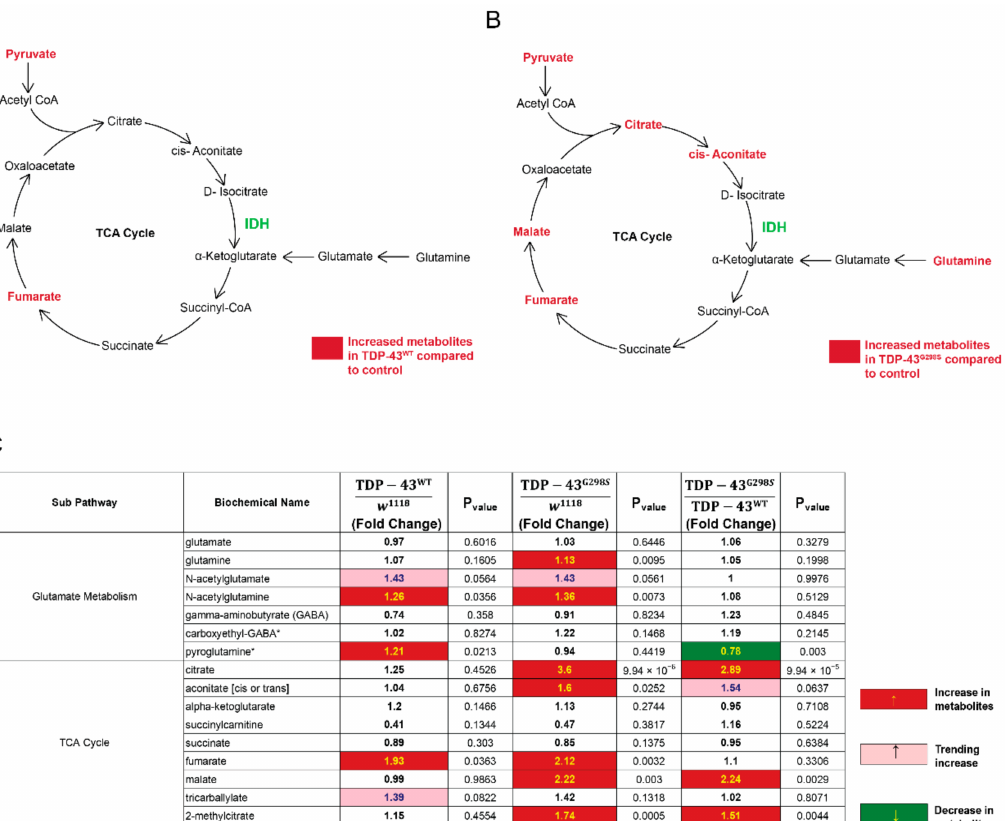
Figure 1. Metabolomic profiling uncovers alterations in TCA cycle and glutamate metabolism. ( A ) TCA cycle and glutamate metabolism components altered in larvae expressing TDP-43 WT . ( B ) TCA cycle and glutamate metabolism components altered in larvae expressing TDP-43 G298S . ( C ) Summary of metabolite fold changes in TDP WT and TDP G298S compared to w 1118 controls, and TDP G298S compared to TDP WT . Red indicates significant upregulation; pink indicates an upward trend; green indicates significant downregulation. Statistical significance was determined using one-way ANOVA. * indicates compounds that have not been officially confirmed based on a standard, but we are confident in its